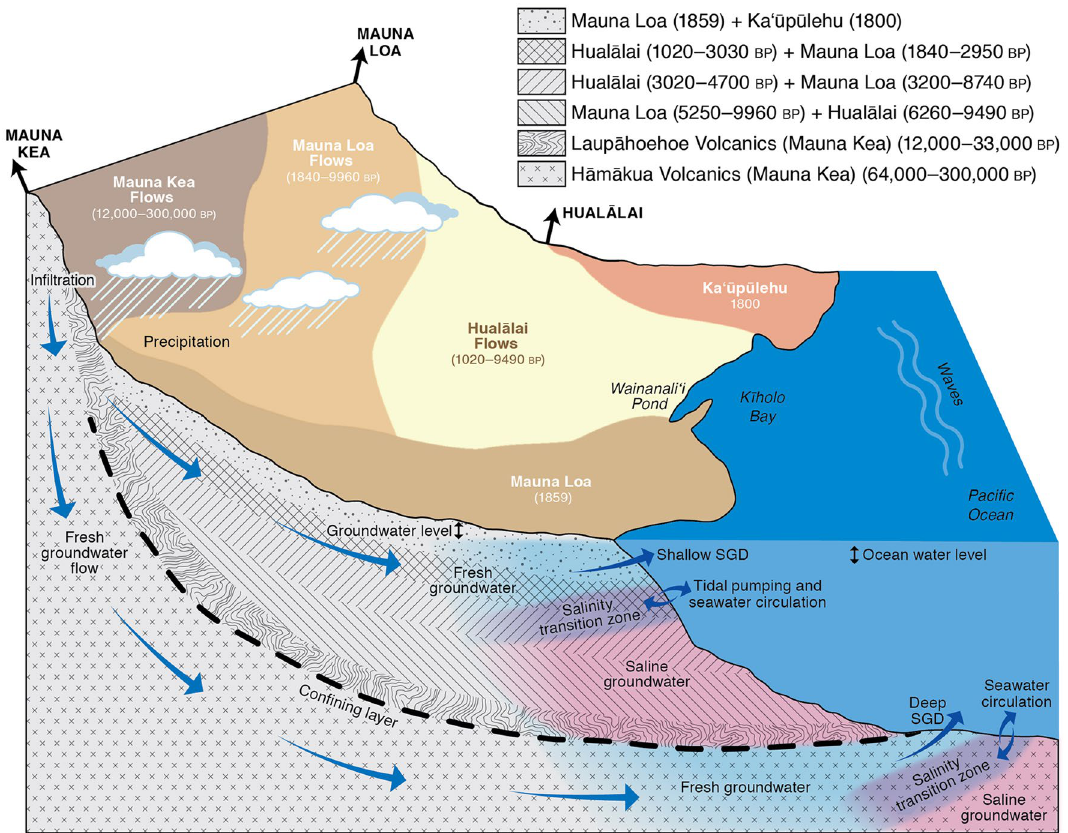
Figure 2. Conceptual cross-section of the study area and processes influencing groundwater levels, SGD, and coastal salinity (not to scale). Locations and ages (years before present, BP) of lava flows are approximated on the surface and with depth according to 26–29 . These historic lava flows are significant as they provide